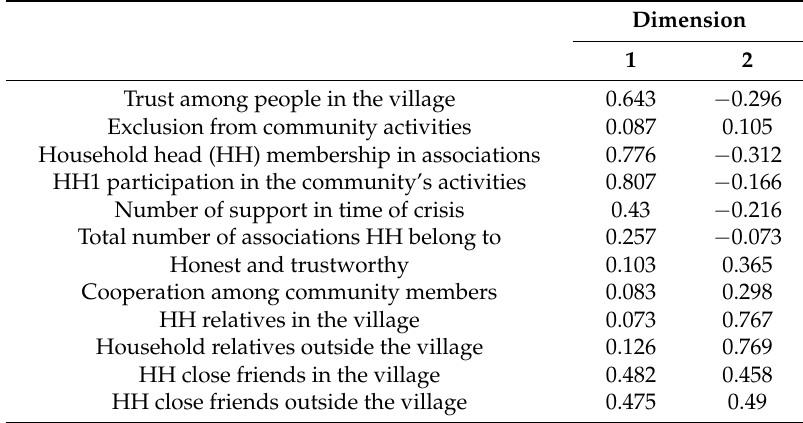
Table A2. Categorical principal components analysis (component loadings).